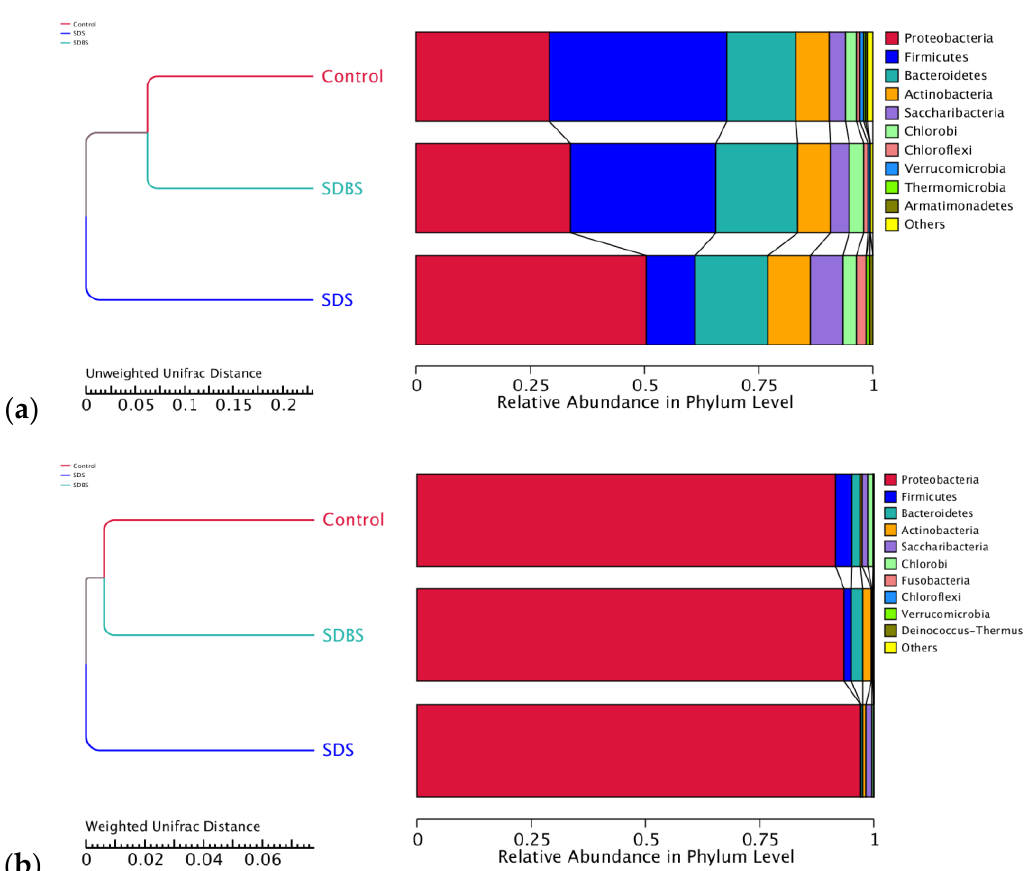
Figure 4. UPGMA analysis based on different algorithms at the phylum level of 3 activated sludge samples: ( a ) the unweighted unifrac distance; ( b ) the weighted unifrac distance.